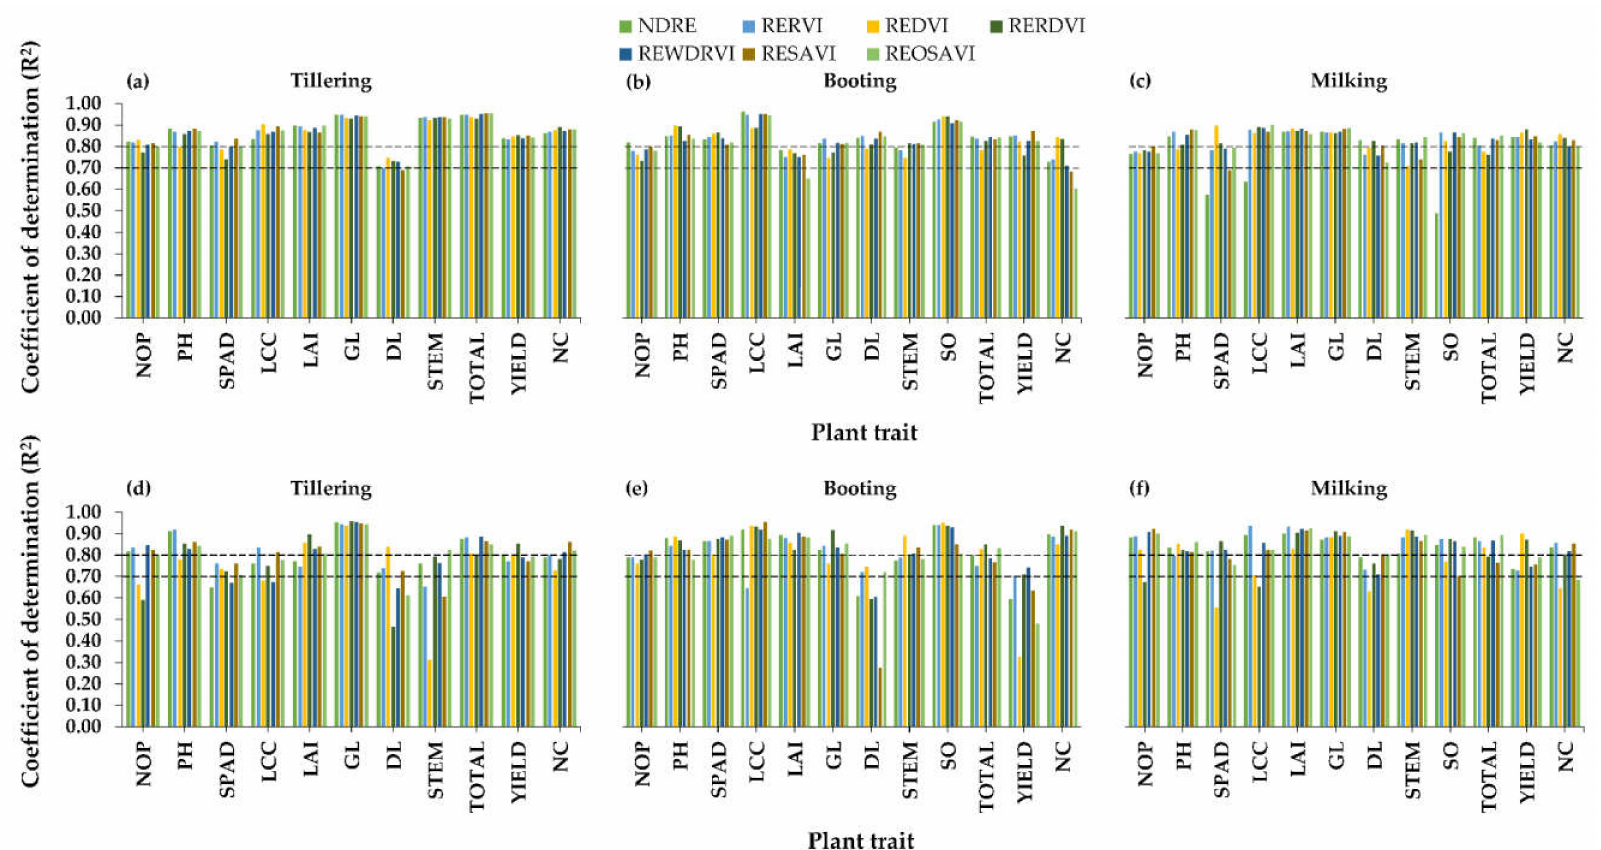
Figure 6. R 2 values for the red-edge-NIR indices’ training ( a – c ) and testing ( d – f ) models for all plant traits at different rice growth